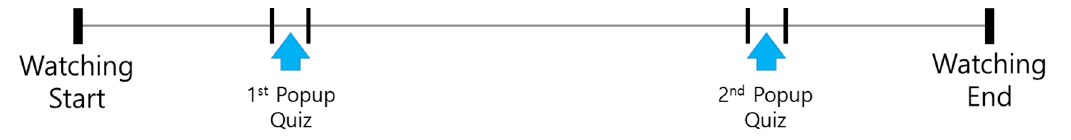
Figure 4. Process of Time Interval Pass.